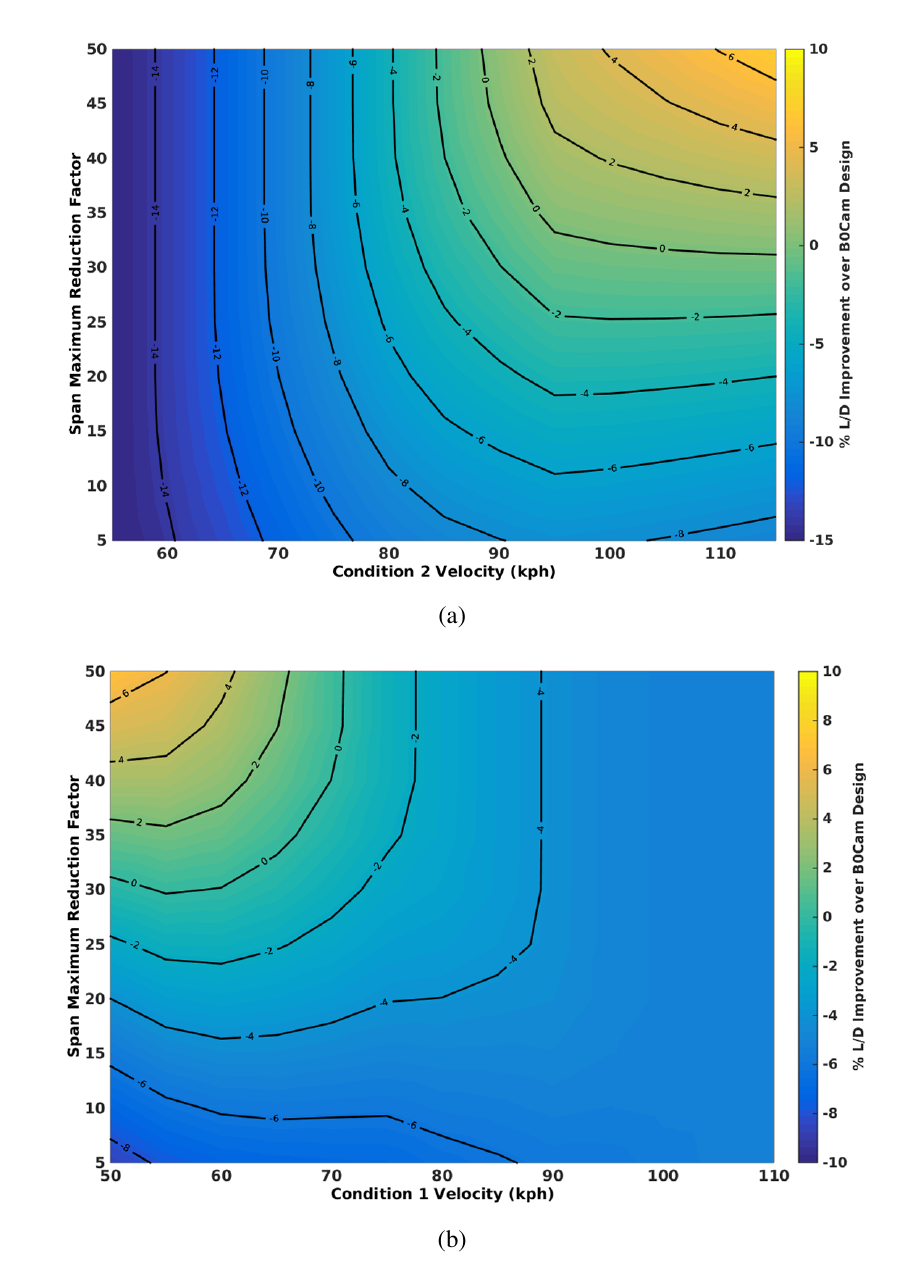
Figure 14. The effect of maximum span modification ( Ψ optimum span with no camber over variable speed ranges normalised to the baseline camber design. ( a ) Aerodynamic efficiency for low speed fixed at 50 kph; ( b ) aerodynamic efficiency for high speed fixed at 115